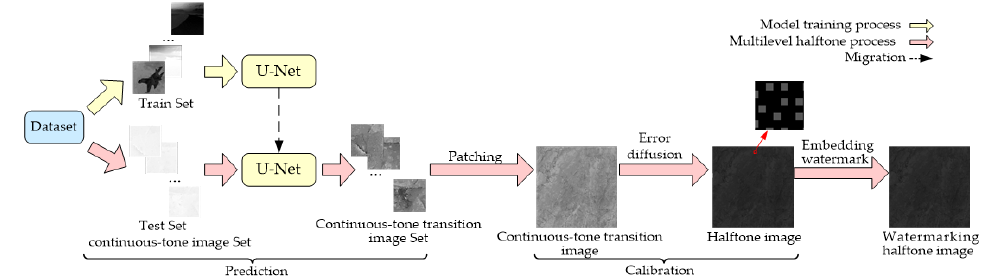
Figure 4. General flowchart.